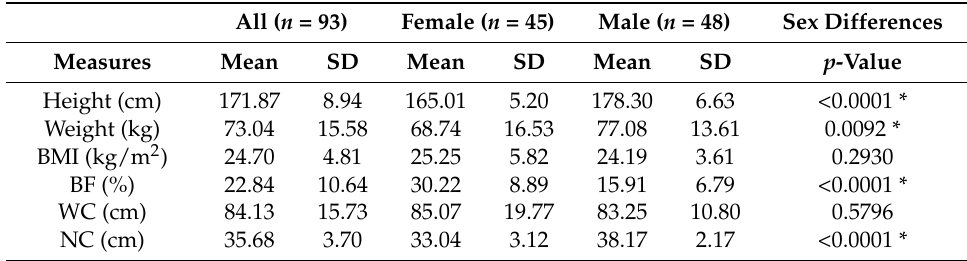
Table 2. Baseline anthropometric measures by sex.